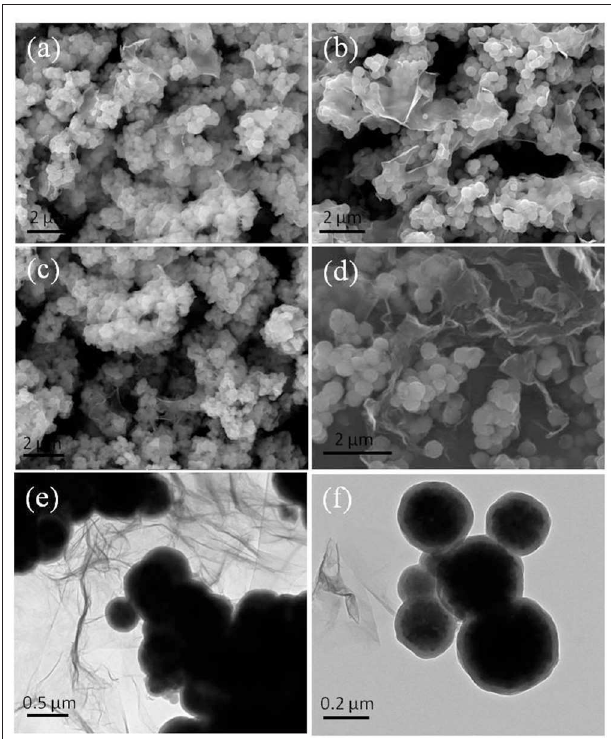
FIGURE 3 | SEM images of the samples after five cycles (a) Fe 3 O 4 @GO-c toward MB, (b) Fe 3 O 4 @GO-e toward MB, (c) Fe 3 O 4 @GO-c toward Pb(II), and (d) Fe 3 O 4 @GO-e toward Pb(II); TEM images of the samples after five cycles (e) Fe 3 O 4 @GO-c toward Pb(II) and (f) Fe 3 O 4 @GO-e toward